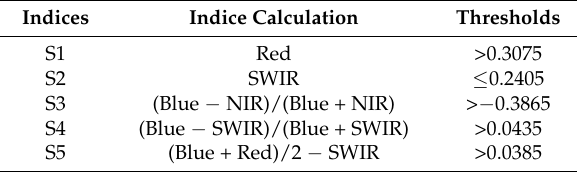
Figure 1. Scheme of the snow classification processing chain of Sentinel-2. Source: [18]. Table 1. Indices and thresholds used in PROBA-V snow classification. Source: [19].